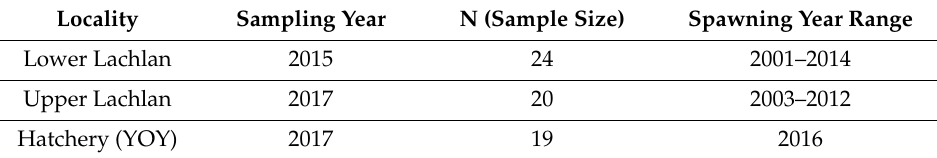
Table 1. Sources of sampled fish in the Lachlan River. Upper Lachlan—upstream of Wyangala dam; Lower Lachlan—downstream of Lake Brewster; Hatchery—Murray Darling Fisheries (located in the Murrumbidgee catchment). The spawning year was calculated using the annual rings in the otoliths. Locality Sampling Year N (Sample